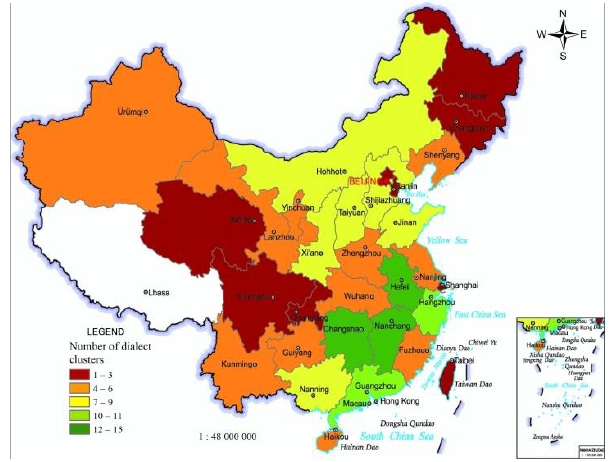
Figure 1. Number of Chinese dialects in the 33 PARs of